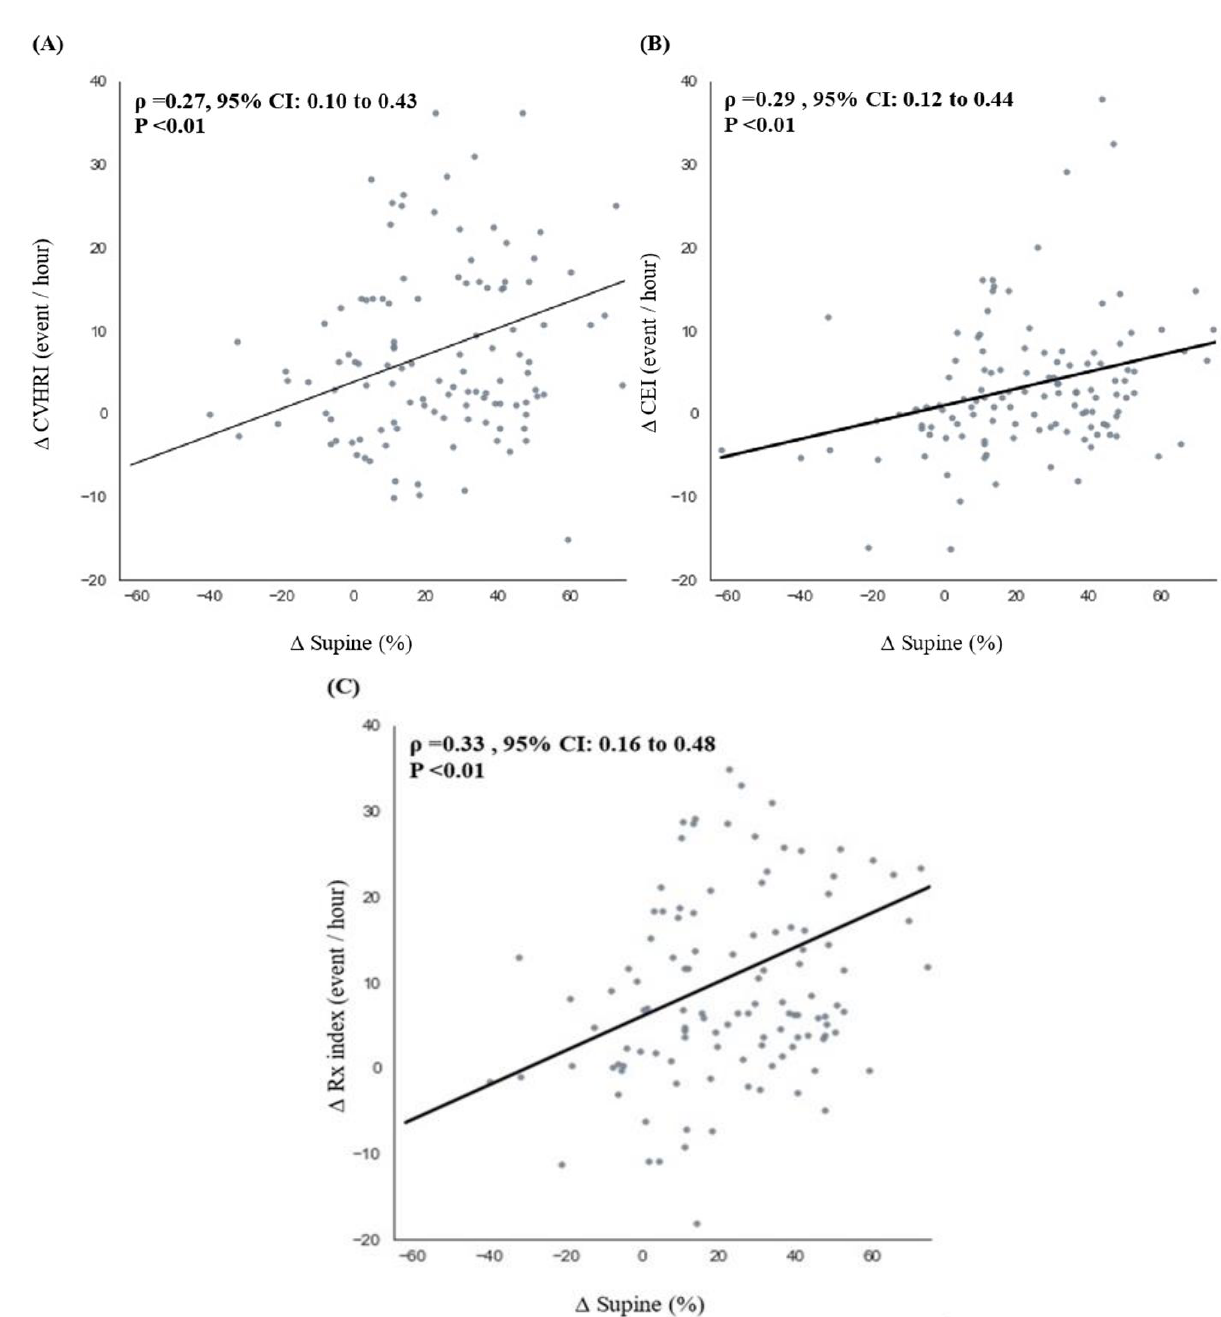
Figure 3. Correlations between the variations in the hospital- and home-based measurements of the percentage of supine sleep time and the RootiRx parameters. Correlation between CVHRI ( A ), CEI ( B ), Rx index ( C ), and variations in the percentage of supine sleep time. Abbreviations: CVHRI, cyclic variation of heart rate index; CEI: chest effort index; Rx index, combination of CVHRI and CEI.